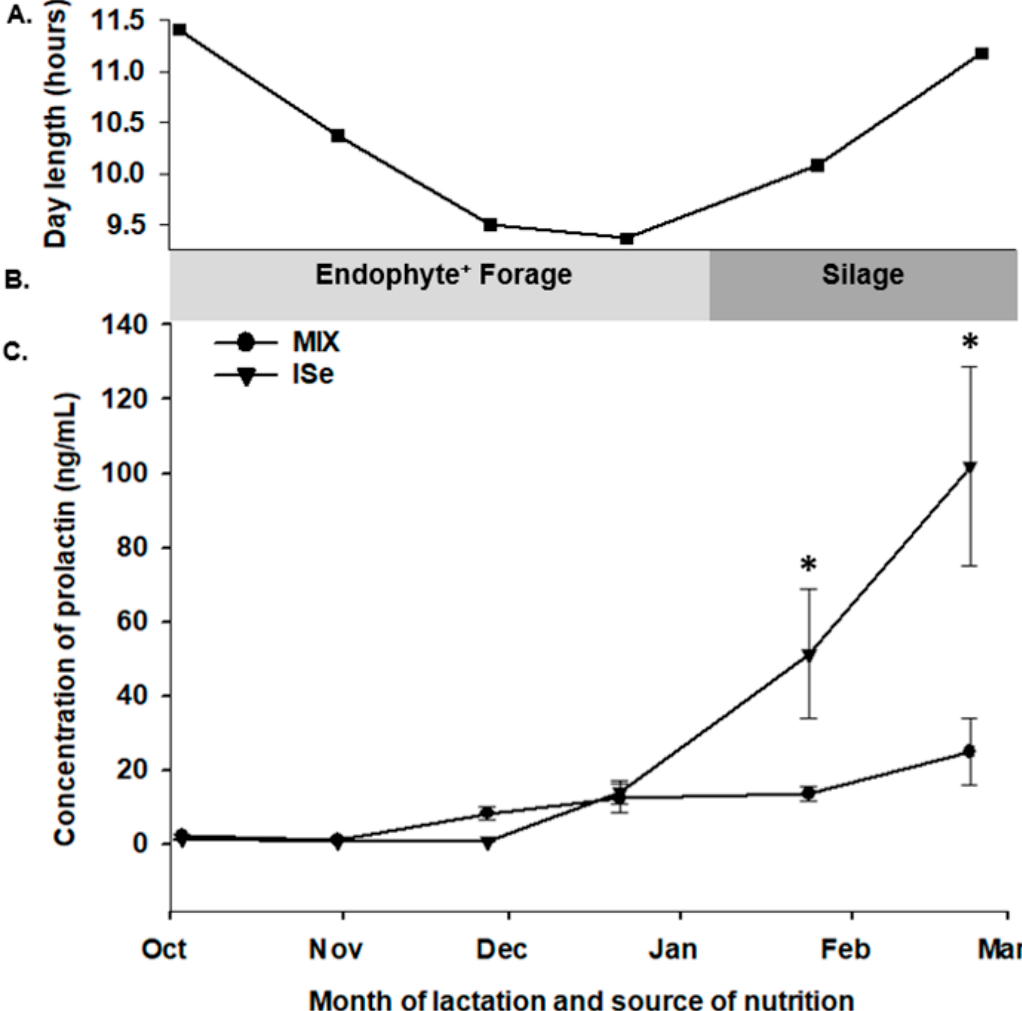
Figure 2. Effect of the form of Se on the systemic concentration of prolactin (PRL) during lactation. ( A ) Day length (hours), ( B ) basal diet (endophyte-infected tall fescue pasture versus silage), and ( C ) serum concentrations of PRL during lactation. Cows had ad libitum access to vitamin-mineral premixes containing 35 ppm of either inorganic (ISe; sodium selenite; n = 12), or a 1:1 combination (MIX) of ISe and OSe (SEL-PLEX; n = 12) selenium. The concentration of PRL was affected by time ( p < 0.001) and treatment by time ( p < 0.001) but not by treatment ( p = 0.8). * The concentration of PRL was elevated in ISe-supplemented cows in the 5th and 6th periods (February and